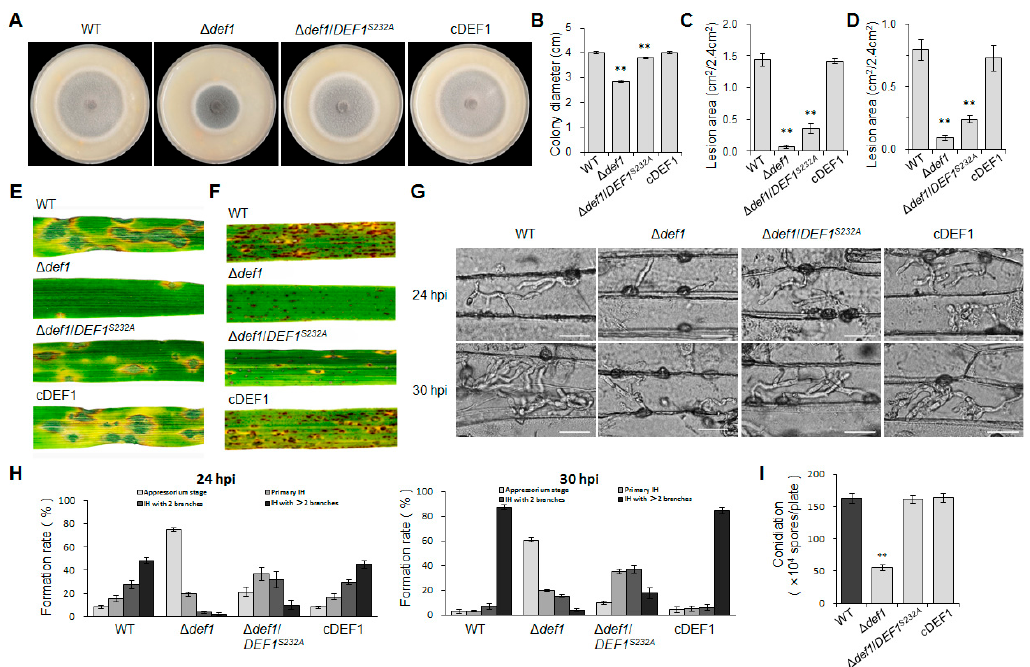
Figure 9. O -GlcNAc modification is required for vegetative growth and pathogenicity of M. oryzae . ( A ) Colony diameters of different strains. Significant differences are labelled with asterisks ( p < 0.01). ( B ) Colony morphology of different strains grown on OTA plates at 28 °C for five days. Significant differences are labelled with asterisks (**, p < 0.01) ( C , E ) Conidial suspension (5 × 10 4 /mL) of different strains were sprayed onto barley leaves and incubated for 5 days, and then measured the lesion area. Significant differences are labelled with asterisks (**, p < 0.01). ( D , F ) Conidial suspension (5 × 10 4 /mL) of different strains were sprayed onto rice leaves and incubated for 5 days, and then measure the lesion area. Significant differences are labelled with asterisks (**, p < 0.01). ( G ) Infection hyphae of different strains in Barley epidermal cells at 24 hpi and 30 hpi. Bar = 20 μm. ( H ) Percentages of appressoria with infection hyphae at different stages. AP, appressorium with no infection hyphae; PH, primary infection hyphae; IH, secondary infection hyphae. WT, wild type; Δ def1 , def1 knock out mutant; Δ def1 / DEF1 S232A , O -GlcNAc site mutant (Ser232 mutated into Ala); cDEF1, complementary strains. ( I )